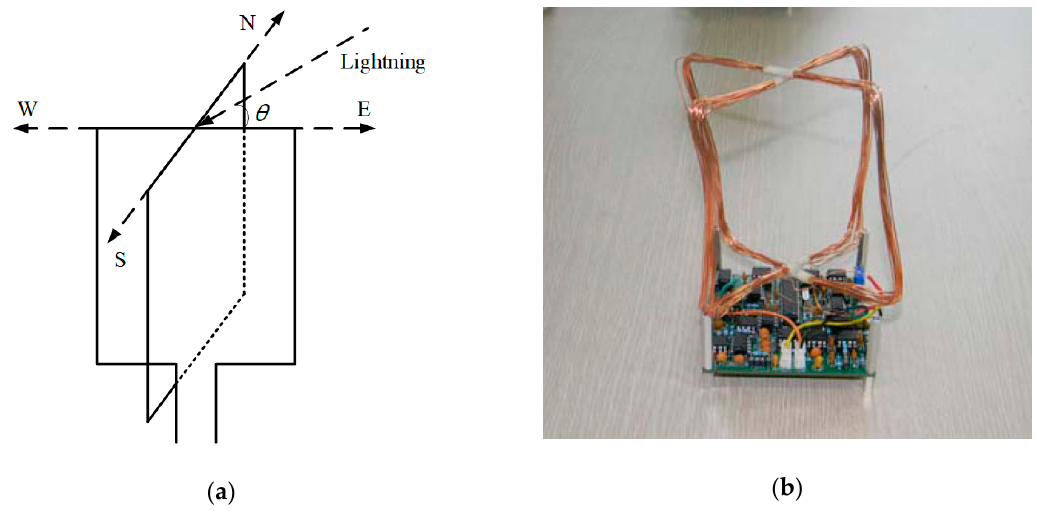
Figure 5. Loop antennas. ( a ) Schematic; ( b ) photograph and detection circuit.